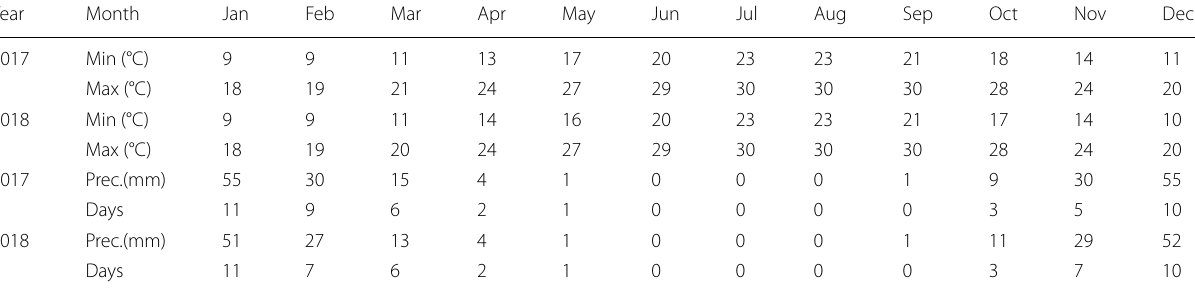
Table 3 Metrological data of the growing period (2017/2018)